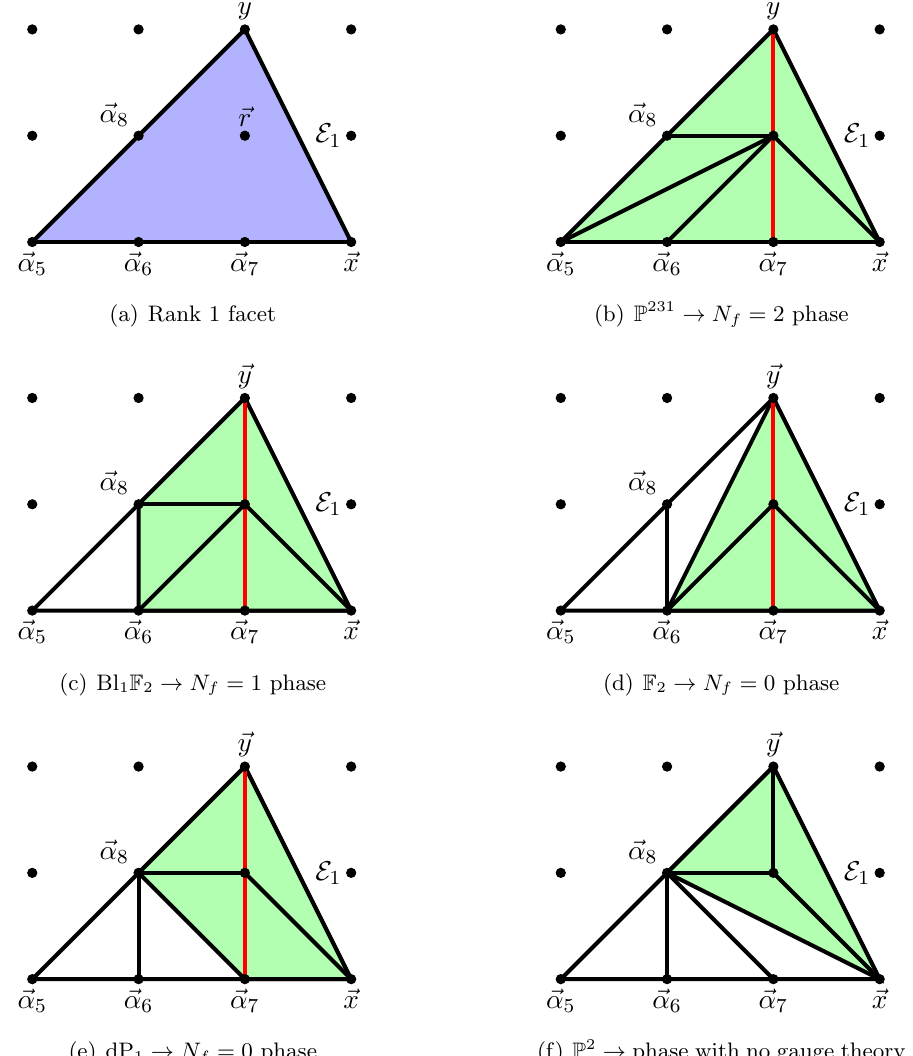
Figure 4 . The full facet (a) of (cid:6) over the edge E 1 (see (cid:12)gure 3) containing one interior vector ~r . Depending on the triangulation of top, which induces di(cid:11)erent triangulations (b){(f) of the facet, the non-(cid:13)at geometry realizes a di(cid:11)erent weakly coupled phase of the rank one 5d SCFT. The similarity between this facet and the base polygon F 10 of (cid:6) is purely coincidental. The red lines indicate a projection of the corresponding toric diagram preserving the cones, and thus a ruling of the toric